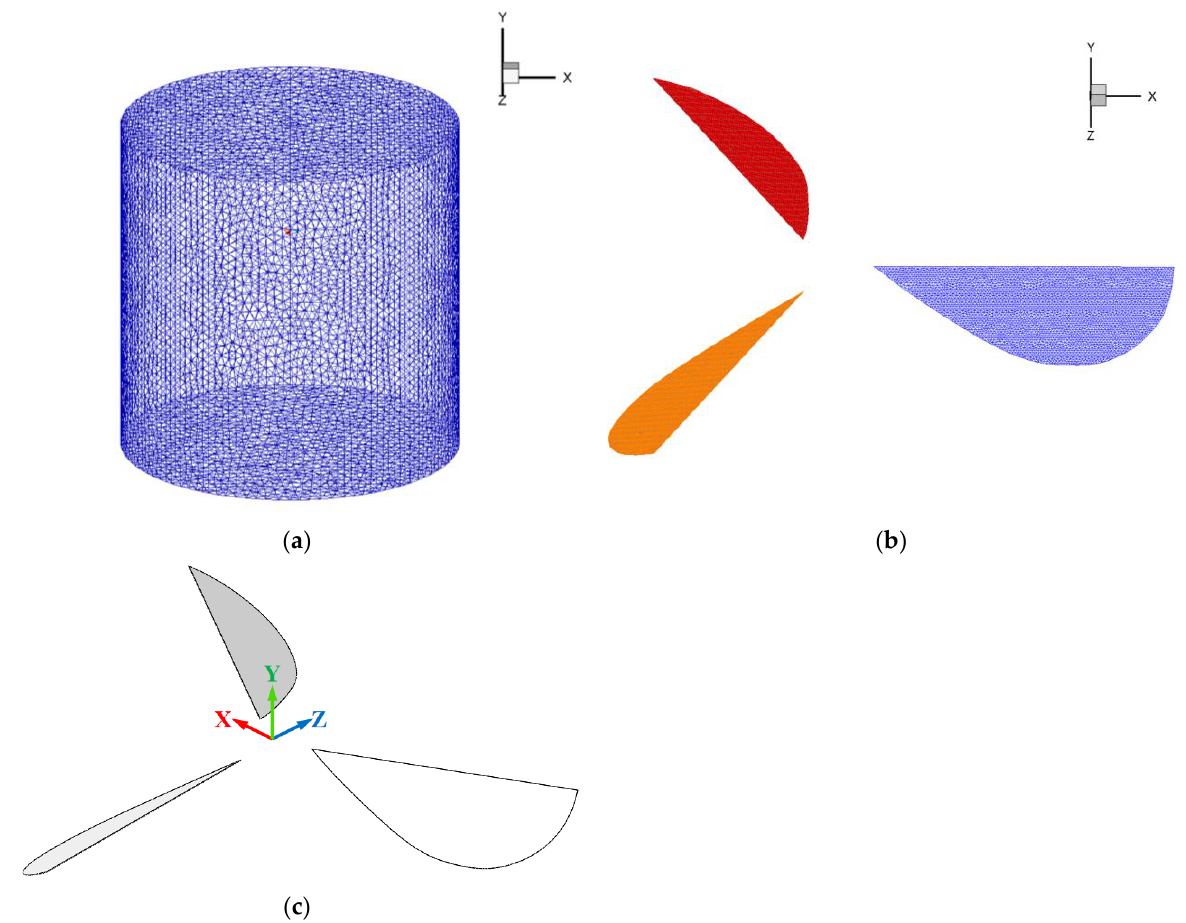
Figure 10. Mesh used in the CFD calculation: ( a ) Computational domain of CFD model; ( b ) Part of computational mesh in wings section; ( c ) The CAD geometry of the computational model.